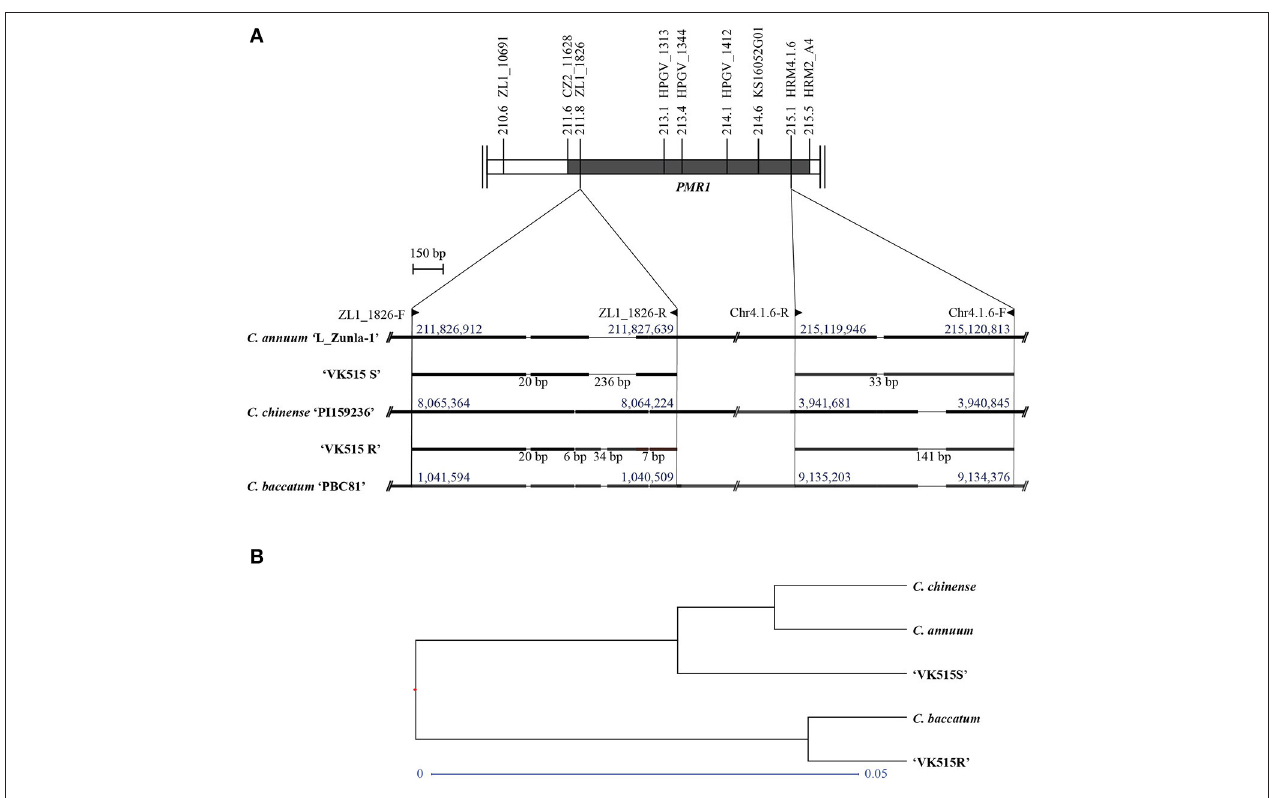
FIGURE 4 | Sequence analysis of the PMR1 locus. (A) Schematic representation of ‘L_Zunla-1’, C. chinense , and C. baccatum PMR1 -specific InDels and corresponding sequences of ‘VK515’ parental lines. InDel lengths in bp are shown below the solid lines. Numbers (blue font) above blocks indicate location on chromosome 4. Primer positions of the PMR1 linked markers are indicated with triangles. (B) Phylogenetic analysis of the PMR1 locus based on GBS data.